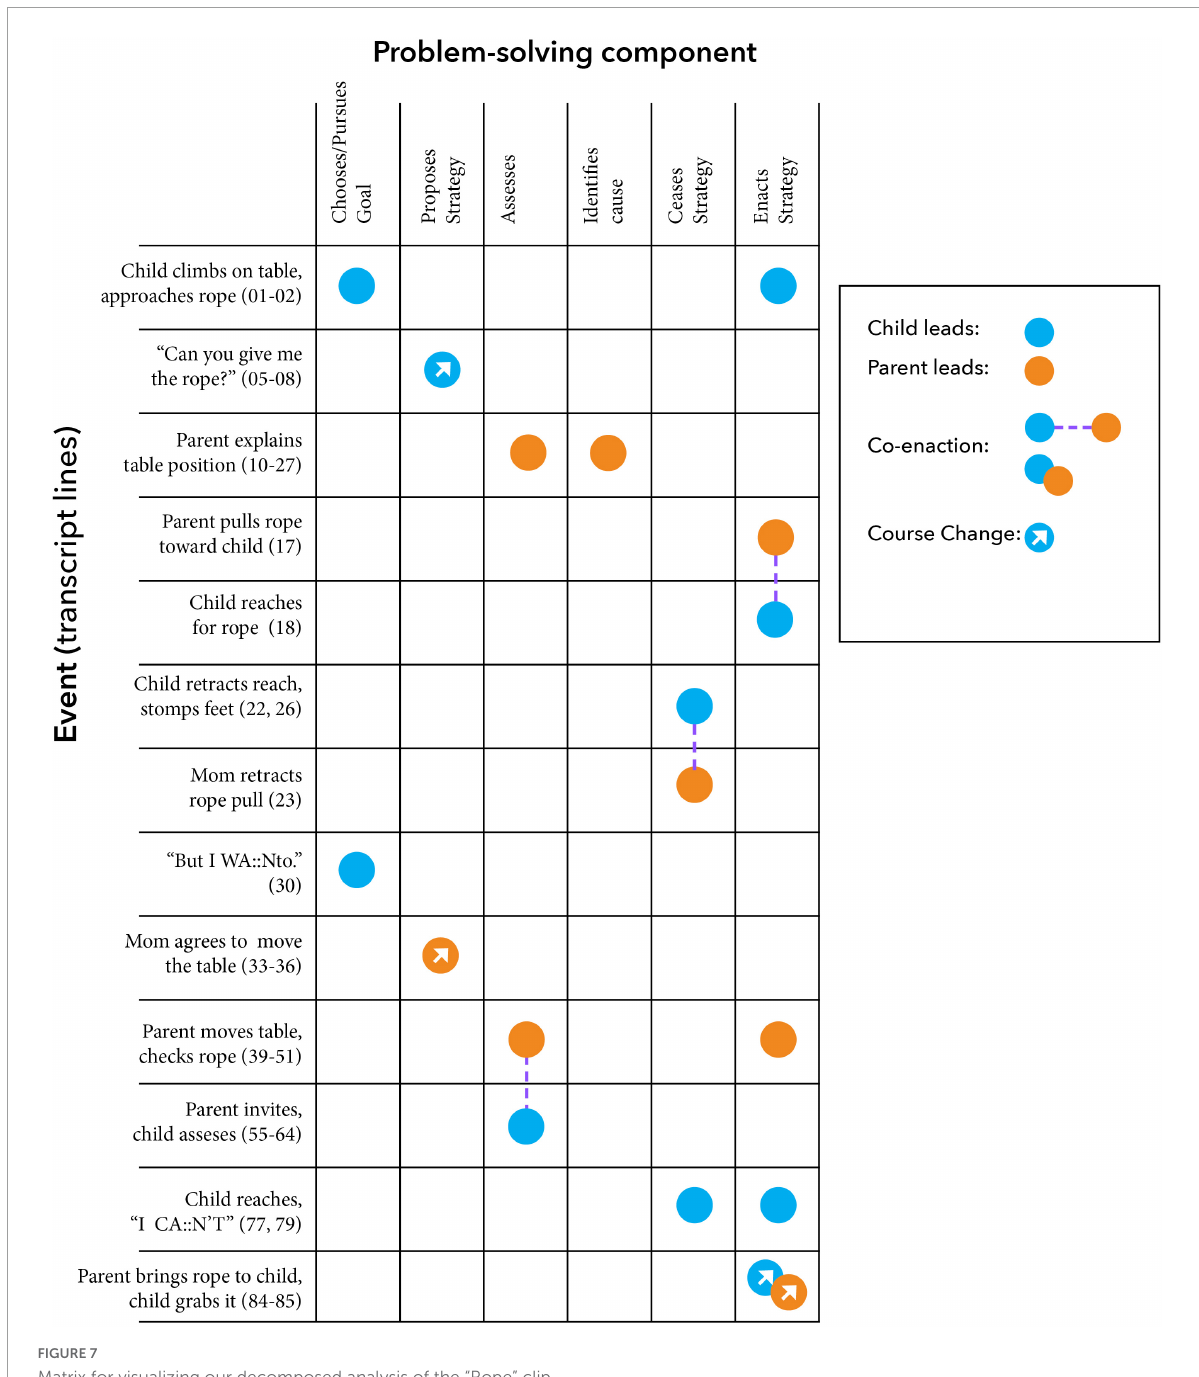
ways that Rae could solve the problem. She could propose that Rae choose a different activity. Her choice, though, is to adjust the backyard’s physical infrastructure so that Rae can access the rope, in the way Rae initially intended, and which would not require Mom’s continued assistance. This intention is evident when Mom moves the table, checks the